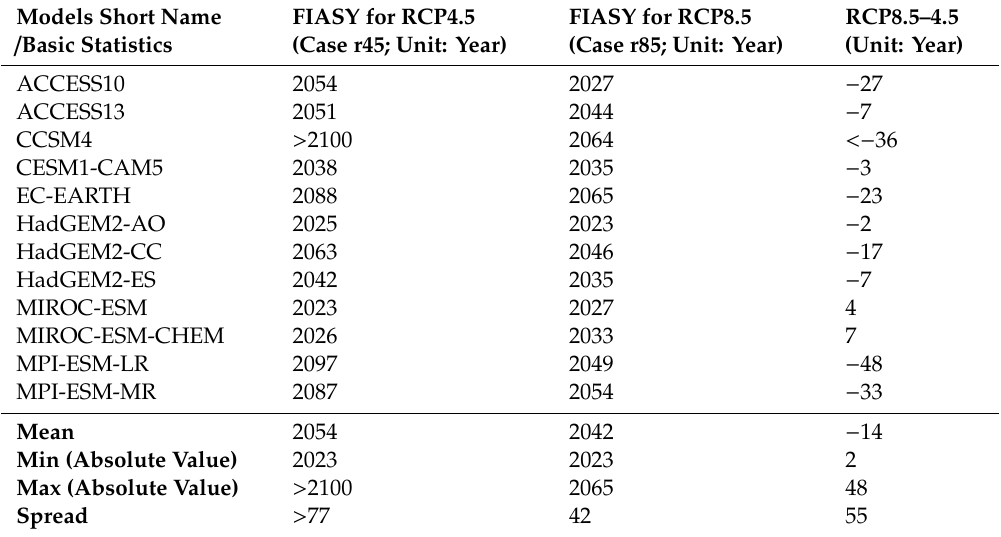
Table 5. The first ice-free Arctic summer year (FIASY) for the RCP4.5 (r45) and RCP8.5 (r85)